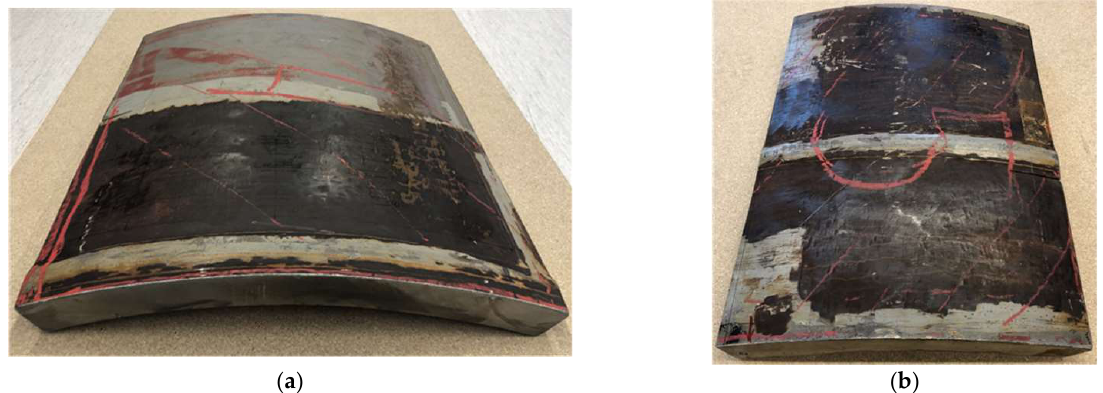
Figure 1. Segments of heat exchanger pipe used for comparison of HTHA detection algorithms: ( a ) sample no. 4 and ( b ) sample no. 5.